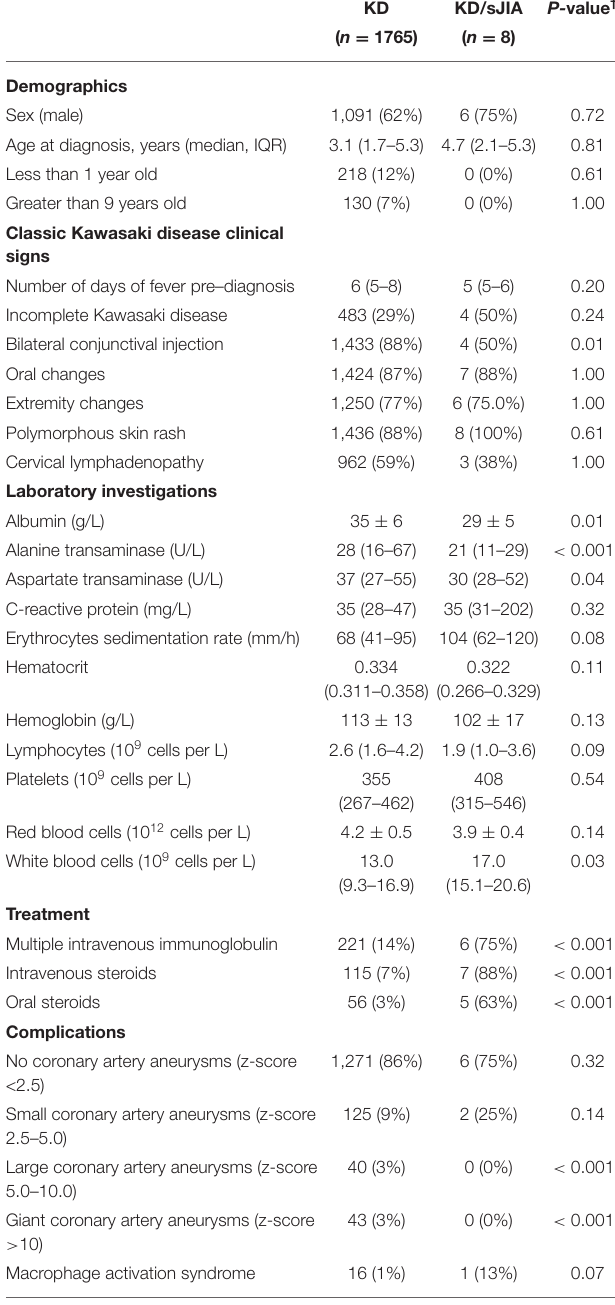
TABLE 1 | Baseline features at diagnosis, medication and